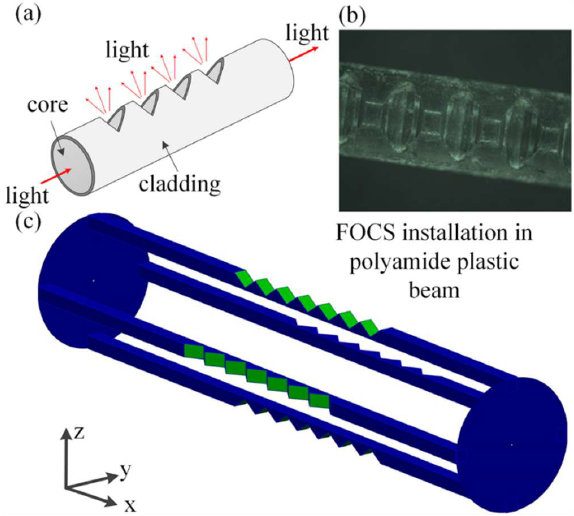
Figure 2. 2D deflection sensor based on FOCS, ( a ) Light propagation; ( b ) Photo of teeth; (c) FOCSs installation within a polyamide beam.